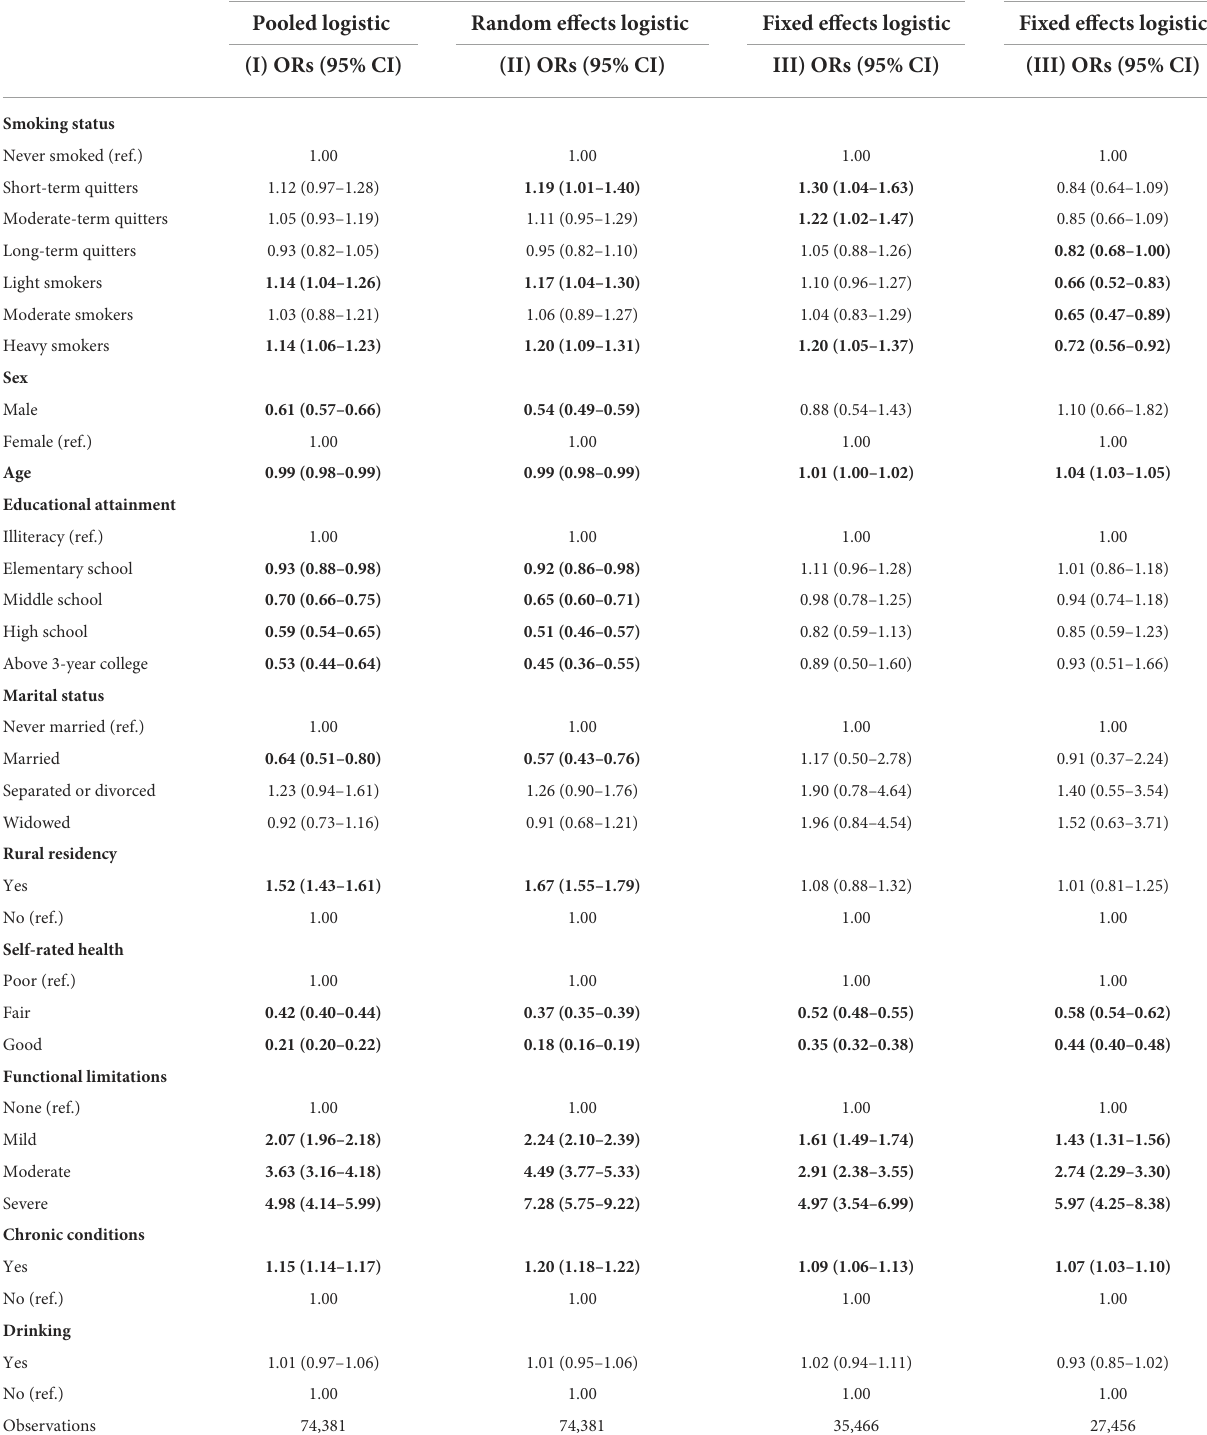
TABLE 4 Logistic regression analysis of depressive